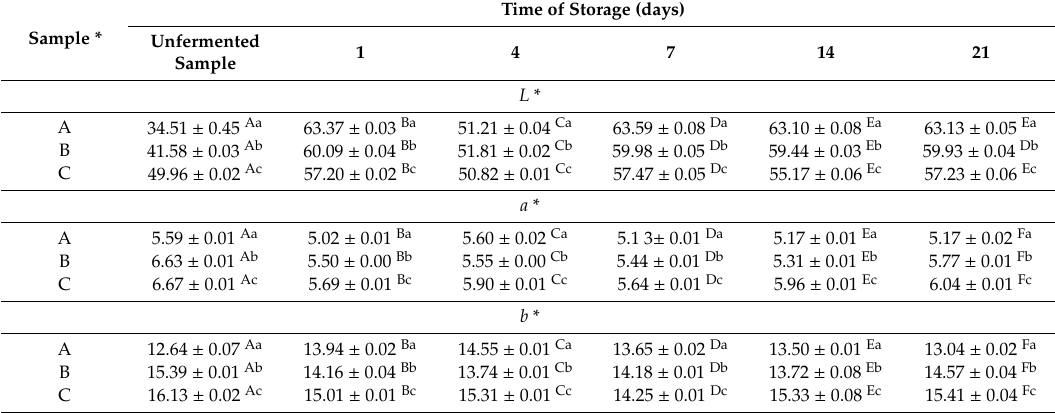
Table 3. Color values of fermented beverages and unfermented (control)